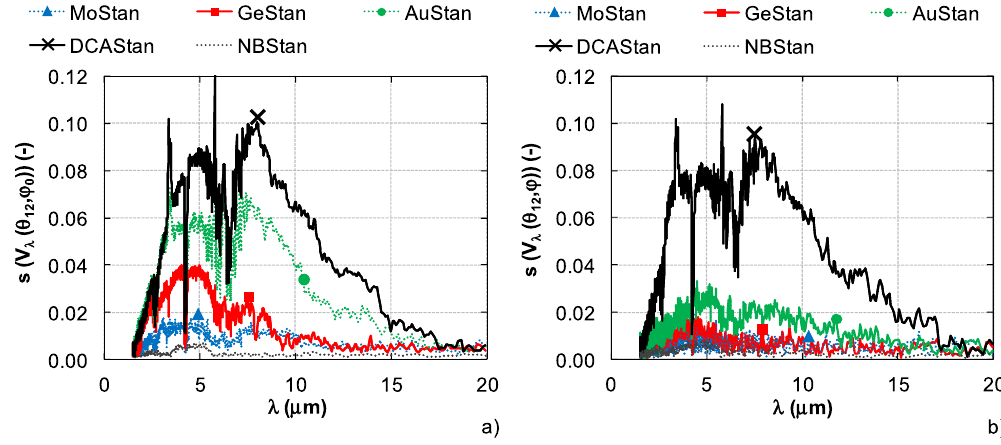
Figure 3. Uniformity of DHR standards. ( a ) Surface uniformity. ( b ) Azimuth angle